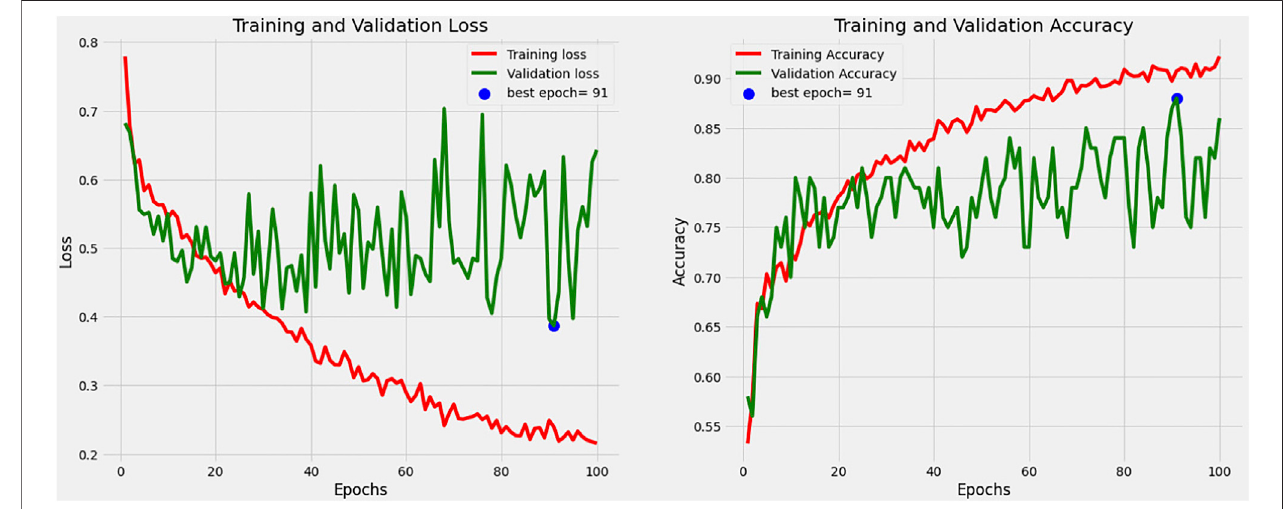
FIGURE 10 | The loss and precision data curves for 100 epochs.